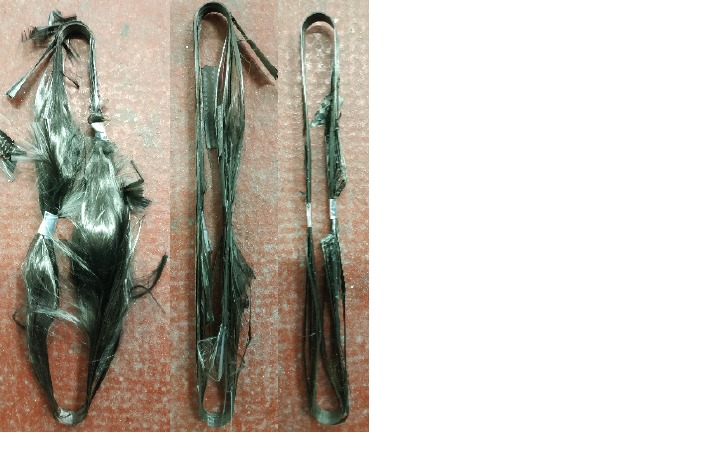
Figure 27. Strap state in TS tests when loaded at 10 kN ( left ), 15 kN ( middle ), and 20 kN ( right ).